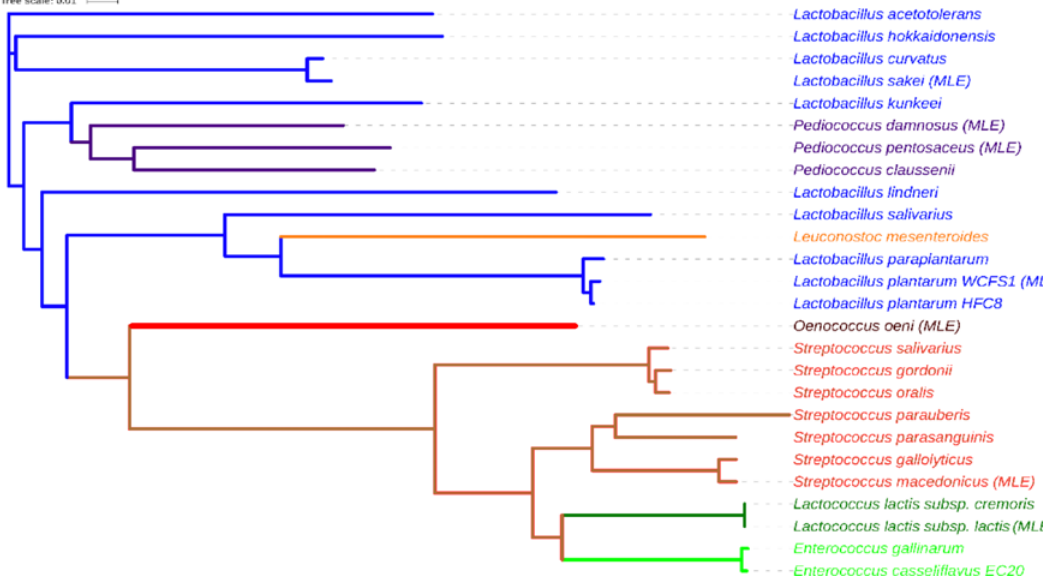
Figure 5. Phylogenetic tree of Lactobacillales constructed on the basis of multiple alignments of homologous sequences to O. oeni MLE, determined by Blastp. The multiple alignments and neighbor-joining tree were built using CLUSTAL OMEGA, and the visualization of the tree was done in iTOL.